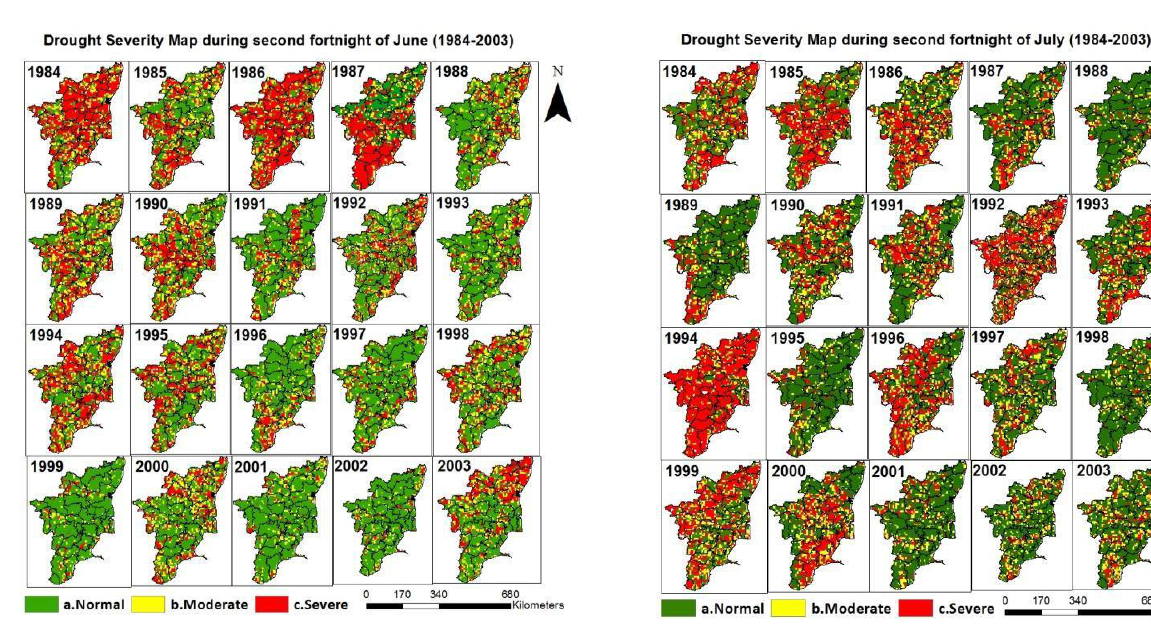
Figure 3 Drought intensity maps for 20 years during June 2nd fortnight